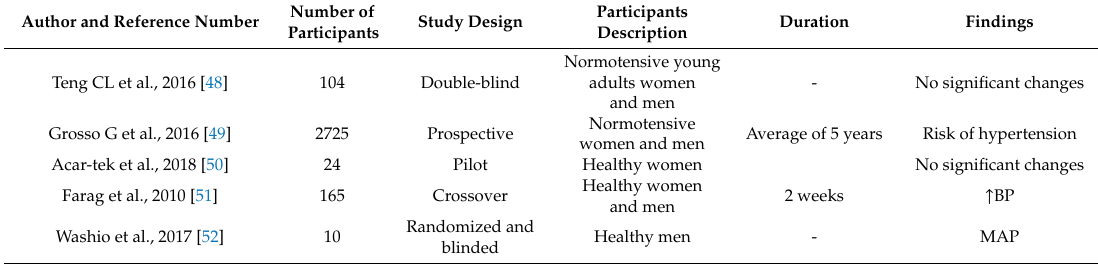
Table 4. Comparison of